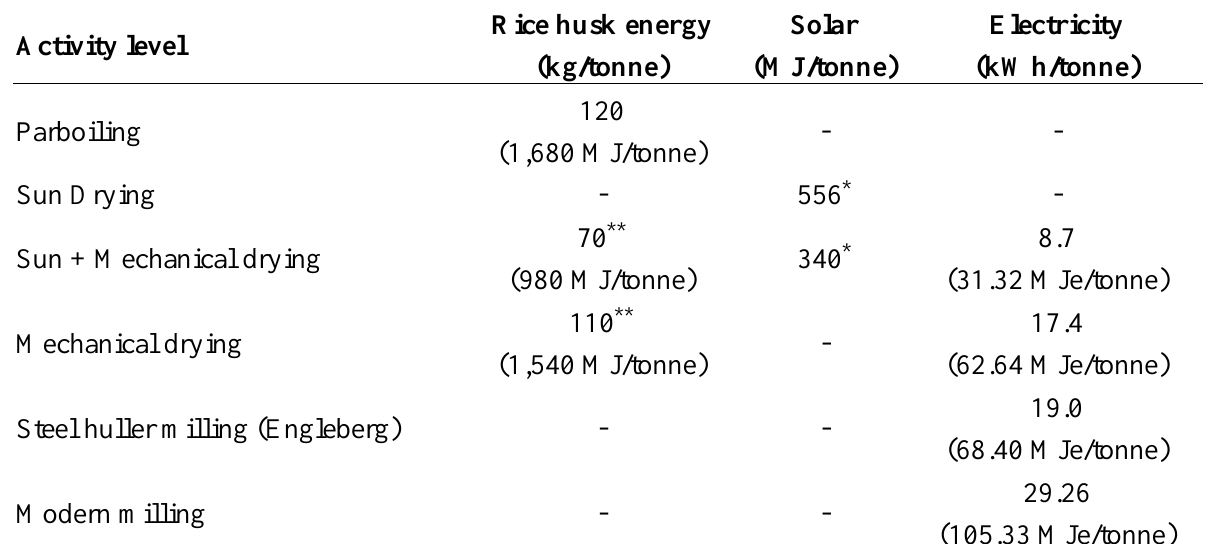
Table 1. Energy intensity of different unit-operation of rice